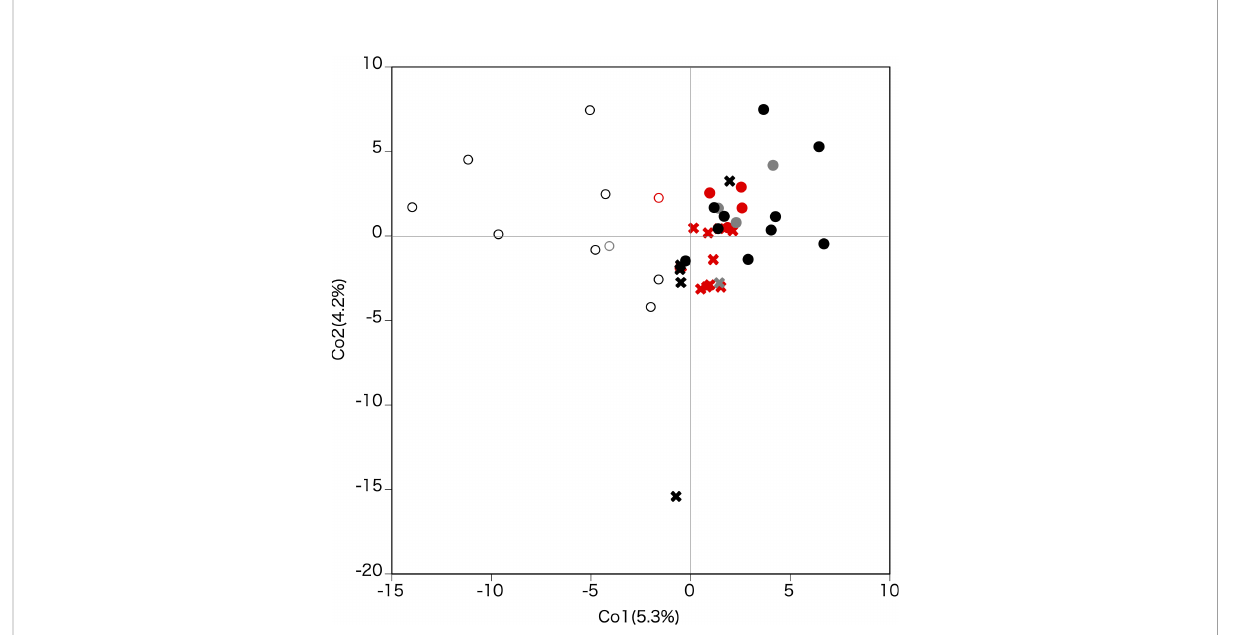
FIGURE 6 Principle coordinate analysis based on the correlation matrix. The fi rst and second axes represent the fi rst and second main components, respectively. Contribution rates of each axis are given in parentheses. Crosses, fi lled circles, and open circles indicate Hokkaido, Okushiri Island, and Tohoku, respectively. Red, black, and grey indicate cpDNA haplotype A, B, and mixed A and B populations,